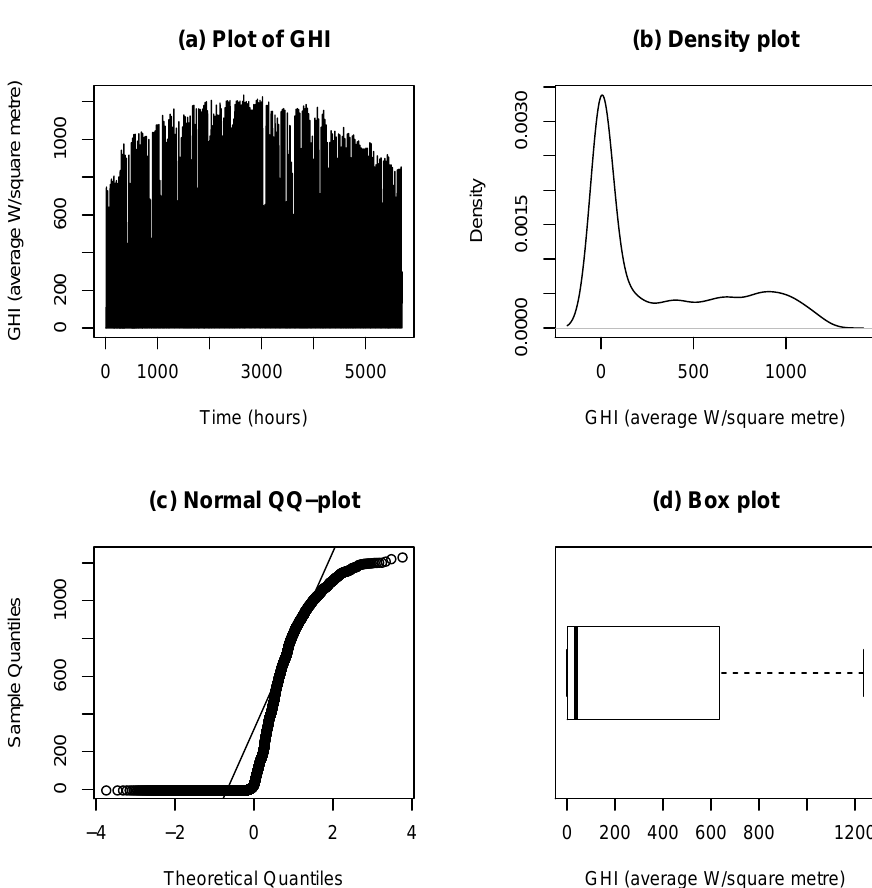
Figure 2. Panel ( a ): Plot of global horizontal irradiance (GHI) (W/m 2 ). Panel ( b ): Density plot of GHI. Panel ( c ): Normal Q-Q plot of GHI. Panel ( d ): Box plot of GHI.